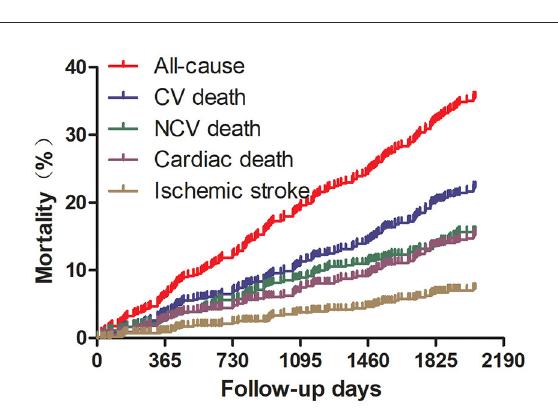
FIGURE2 Cumulative incidences of death for specific causes. CV, cardiovascular; NCV, non-cardiovascular.